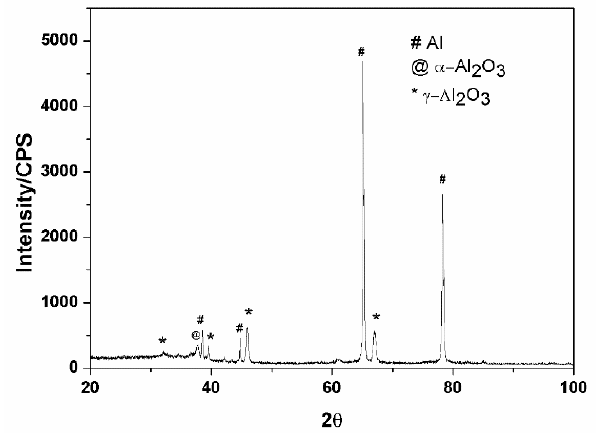
Figure 4. XRD analysis of the ceramic coatings.